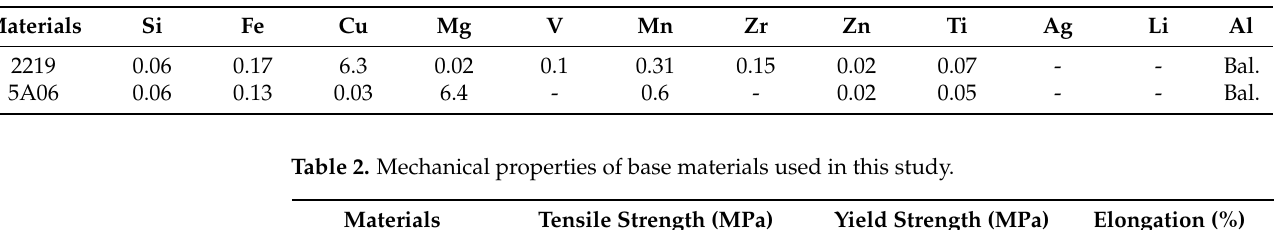
Table 1. Chemical composition (wt.%) of base materials used in this study.